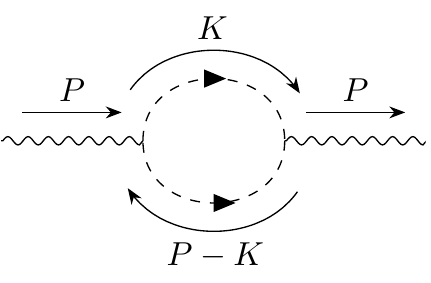
Figure 2 . The one-loop diagram in scalar